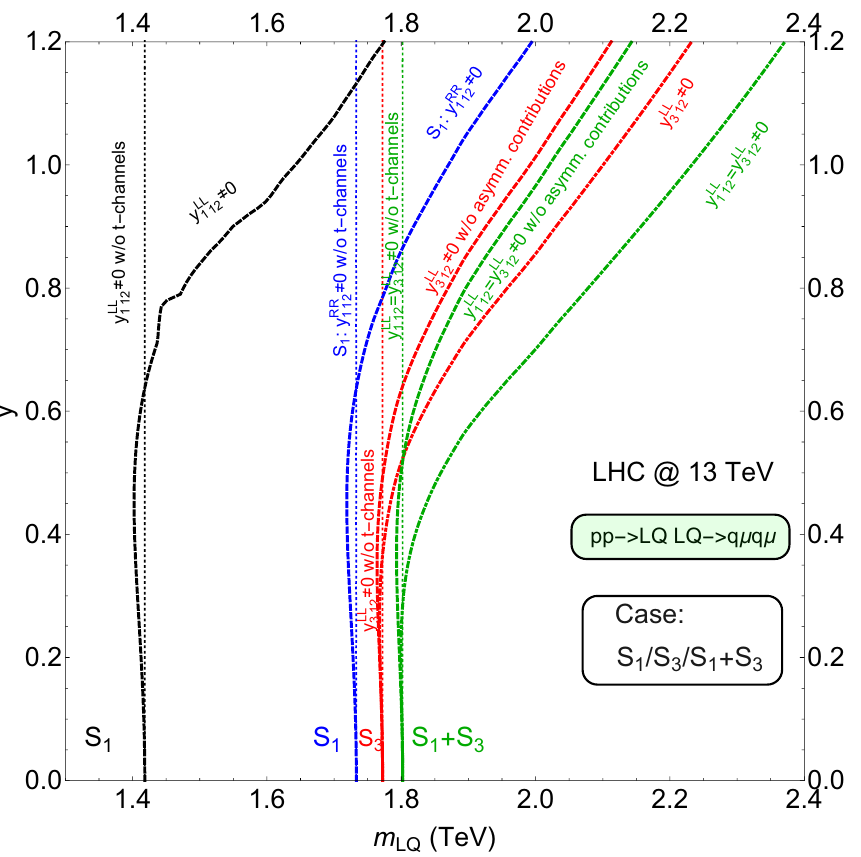
Figure 10 . The leptoquark parameter space limits for the S 1 , S 3 , and S 1 + S 3 scenarios extracted from the pp → LQLQ → jjµµ process search [1] performed at 13 TeV center-of-mass energy of proton-proton collisions at the LHC, using an integrated luminosity of 139 fb − 1 . See text for more